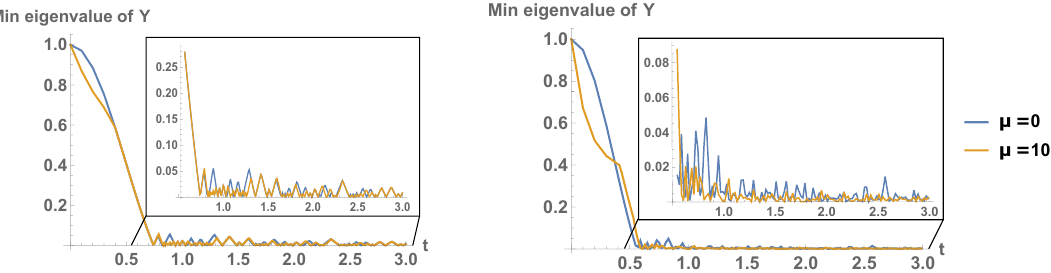
Figure 7 . The smallest eigenvalue of the super-operator Y µ for the SYK model with the integrable 4-body deformation δH 1 , with N = 6 (left) and N = 8 (right) for µ = 0 (blue) and µ = 10 (gold). The values for t & 0 . 5 are displayed inset for visual clarity.